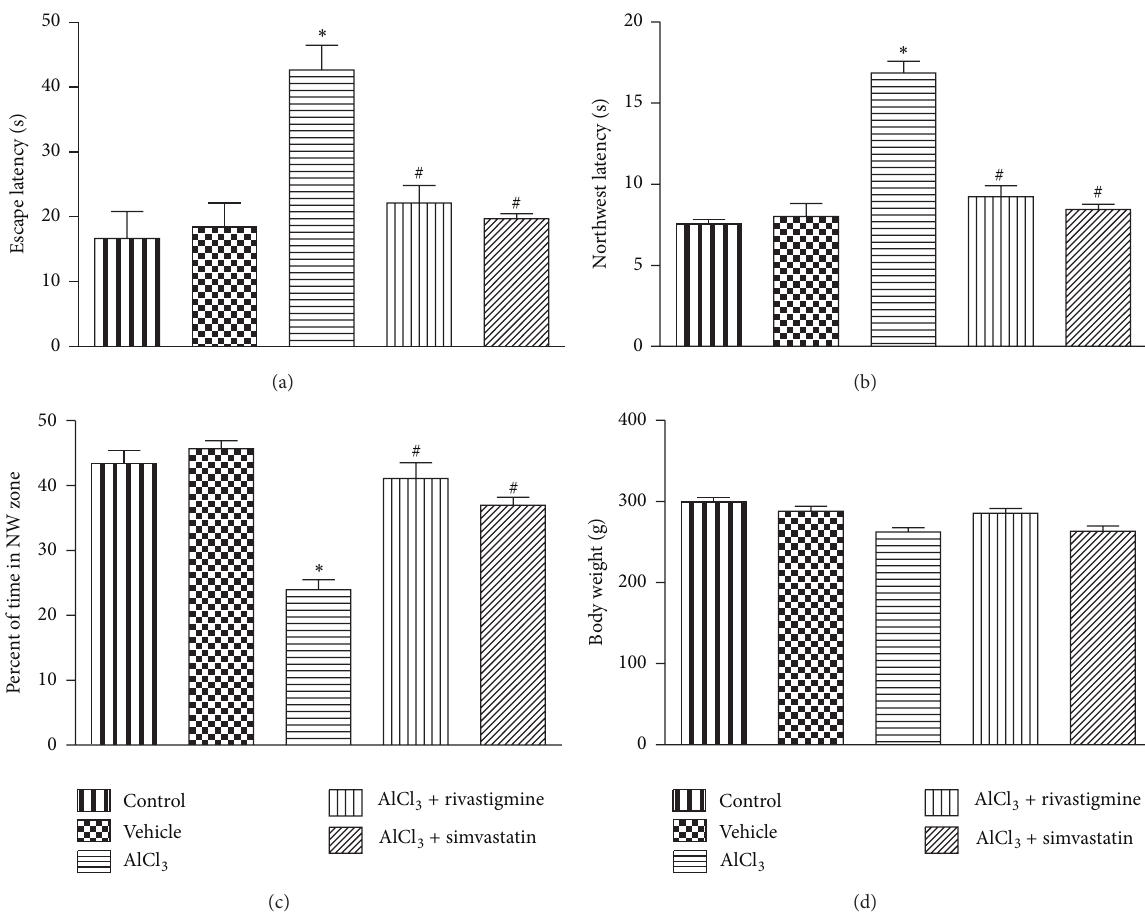
Figure 1: Effect of AlCl 3 and AlCl 3 + treatments on (a) escape latency time (latency to reach platform), (b) northwest latency, (c) percent of time spent in target quadrant (NW), and (d) body weight during retention trial after treatment. Data are presented as mean ± SEM ( 𝑛 = 8 ). ∗ 𝑃 < 0.05 as compared to control group and # 𝑃 < 0.05 as compared to AlCl 3 treated